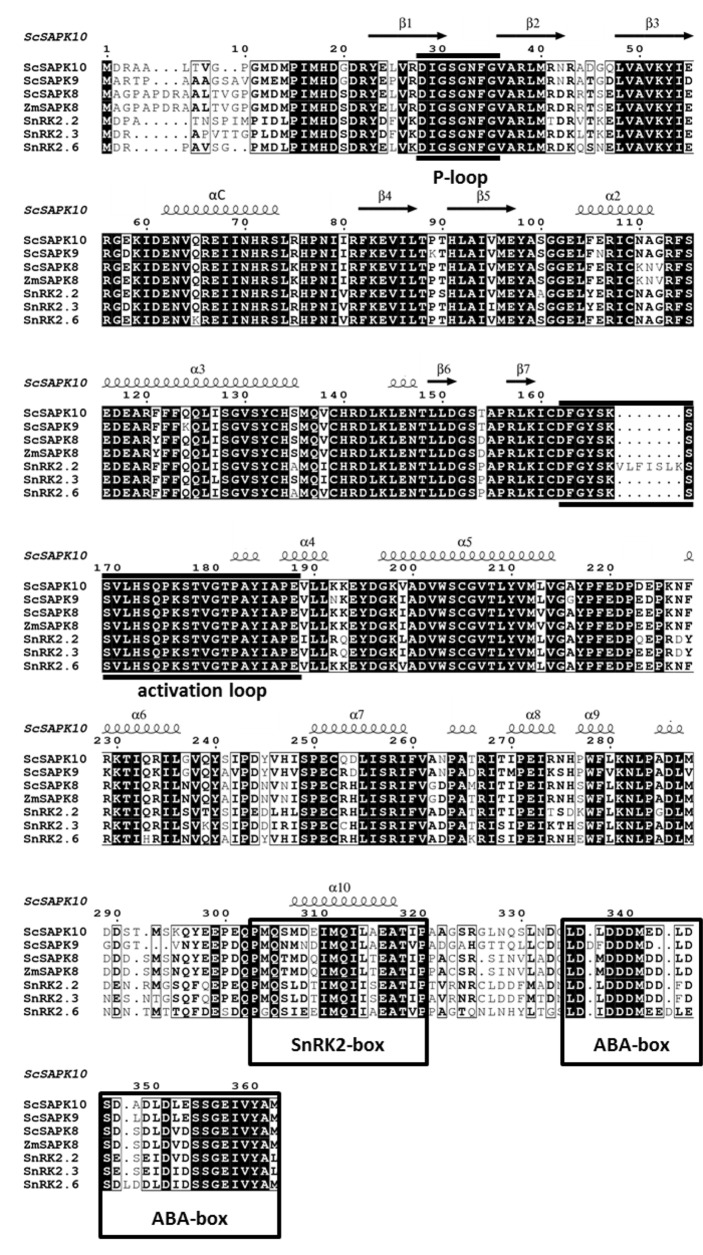
Multiple-sequence alignment of ABA-related SnRK2s shows high similarity and identity between Arabidopsis, maize and sugarcane sequences. Black boxes highlight identical residues, residues in black font have similar chemical properties. Sequences corresponding to the P-loop, activation loop and the regulatory domains SnRK2 box and ABA box are marked based on previous studies (Ng et al., 2011).